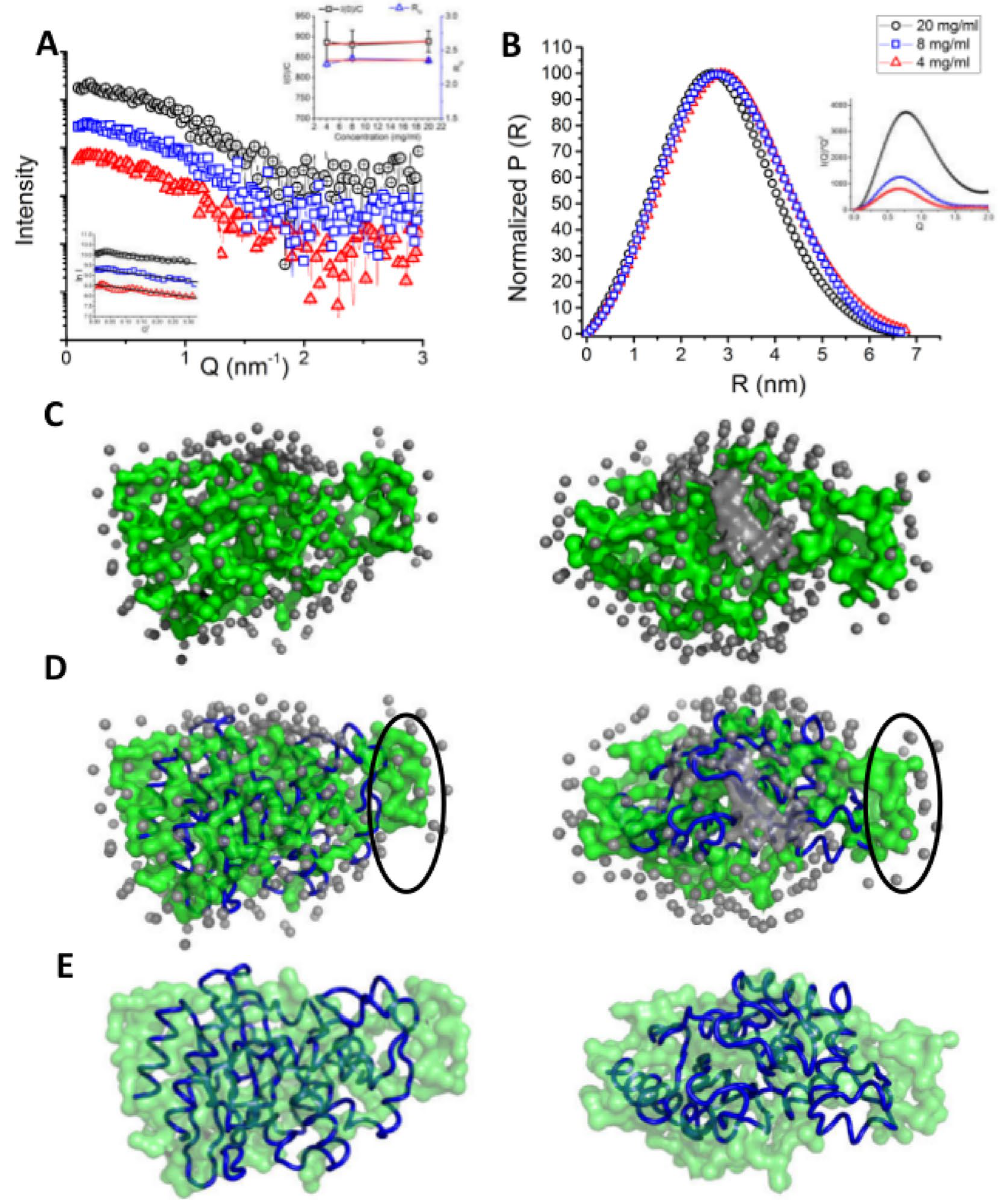
Figure 3. SAXS data analyses and modelling for BlaC. ( A ) SAXS intensity profiles of purified BlaC at three concentrations i . e . 4, 8 and 20 mg/ml with the Guinier plots in lower inset. The black lines show the linear fits. The upper inset has the plots of I 0 /C and R G as a function of protein concentration. ( B ) The pairwise distance distribution functions (P(R)) of the SAXS datasets with the Kratky plots in inset. ( C ) Two orthogonal views of averaged dummy residue based models of BlaC. ( D ) Two orthogonal views of the crystal structure of ß-lactamase (PDB ID: 2GDN, blue tube) superimposed on the SAXS derived model. The unoccupied space is highlighted with black ovals. ( E ) Two orthogonal views of the SAXS model superimposed with the crystal structure with the water molecules hidden for better